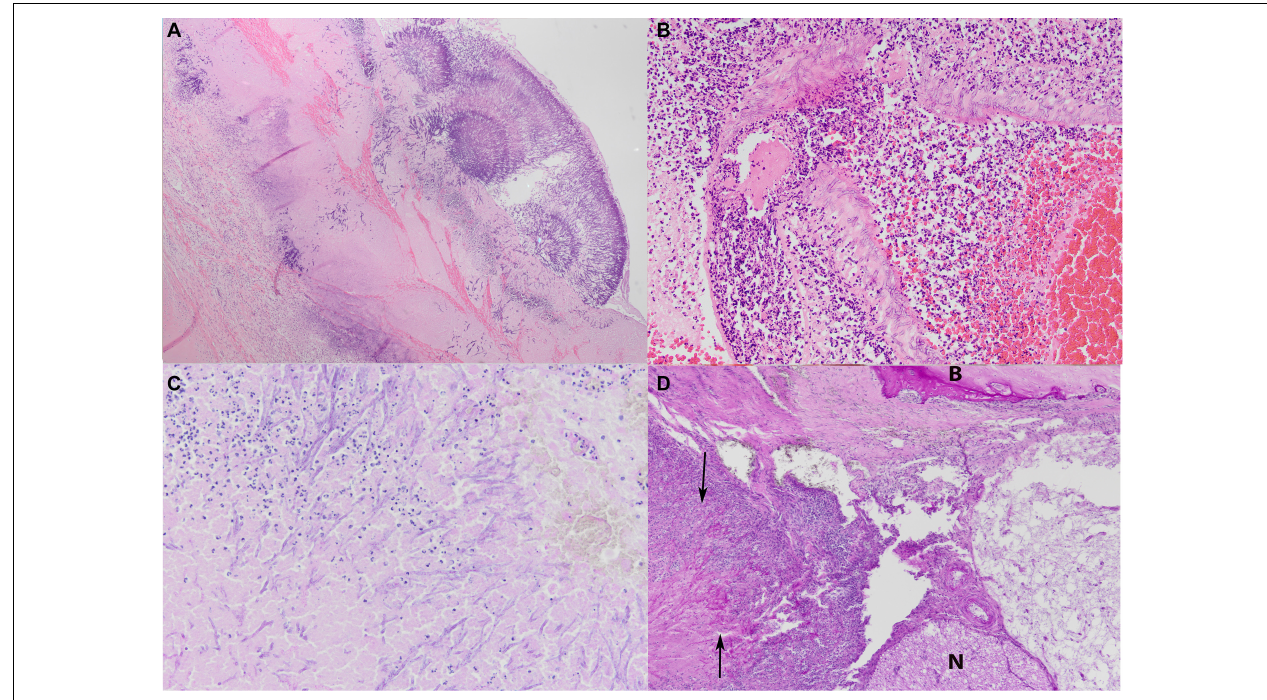
FIGURE 3 | (A) Occlusive bronchitis in case #18 with extensive necrosis of the bronchial epithelium and presence of fungal hyphae into the bronchial cartilage (HE stain, microscopic magnification × 4). (B) Extensive necropurulent to pyogranulomatous vasculitis in cerebrum of case #17 (HE stain, microscopic magnification × 20). (C) Extensive necropurulent to pyogranulomatous meningoencephalitis of case #15 (PAS stain, microscopic magnification × 20). (D) Severe necropurulent otitis media with necrosis and erosion of the periotic bone, extensive fibrosis and inflammatory infiltrates (arrows) in case #15, with B indicating the bone tissue and N the nervous tissue (HE stain, microscopic magnification ×